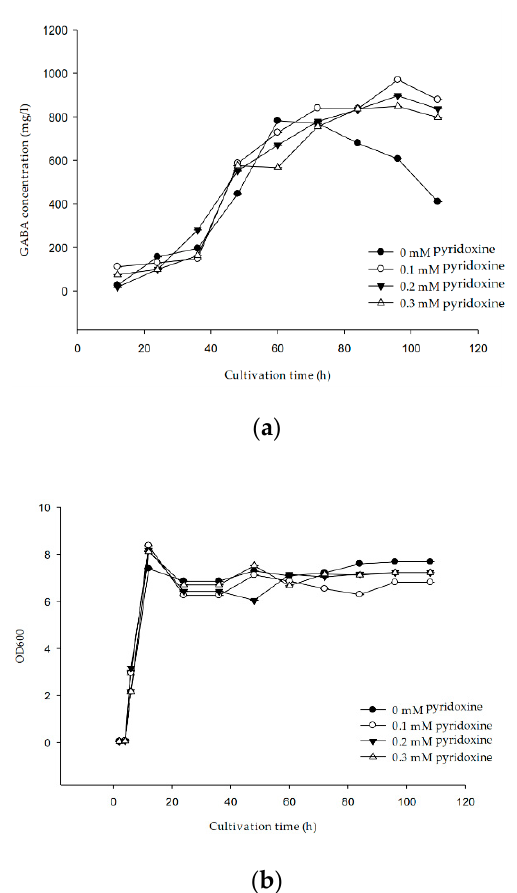
Figure 4. Effect of pyridoxine on ( a ) GABA production and ( b ) cell growth during the cultivation of L. plantarum FNCC 260. The MRS medium was supplemented with 118 mM MSG and various concentrations of pyridoxine 0, 0.1 mM, 0.2 mM, 0.3 mM. The strain was incubated at 37 °C for 108 h. Data expressed as mean ±SD with SD less than 5%. The experiments were conducted at least in duplicates.